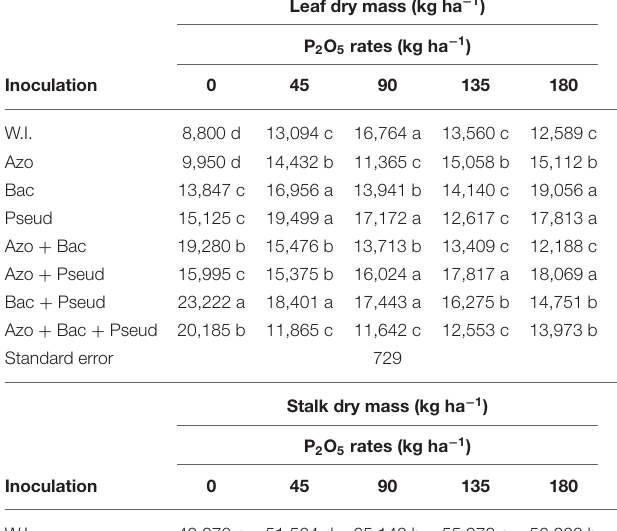
TABLE 6 | Interactions between different bacterial inoculations and P 2 O 5 doses for leaf dry mass, stalk dry mass and total dry mass in sugarcane crop. Leaf dry mass (kg ha − 1 )